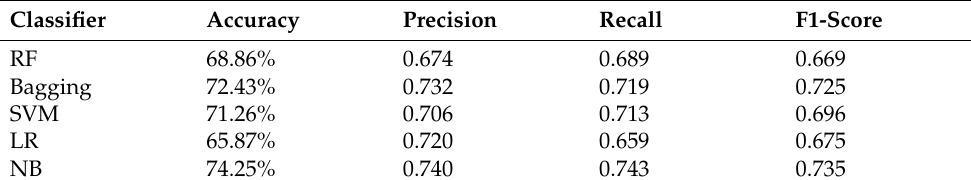
Table 10. Experiments with ML models and BoW on original sentiments.